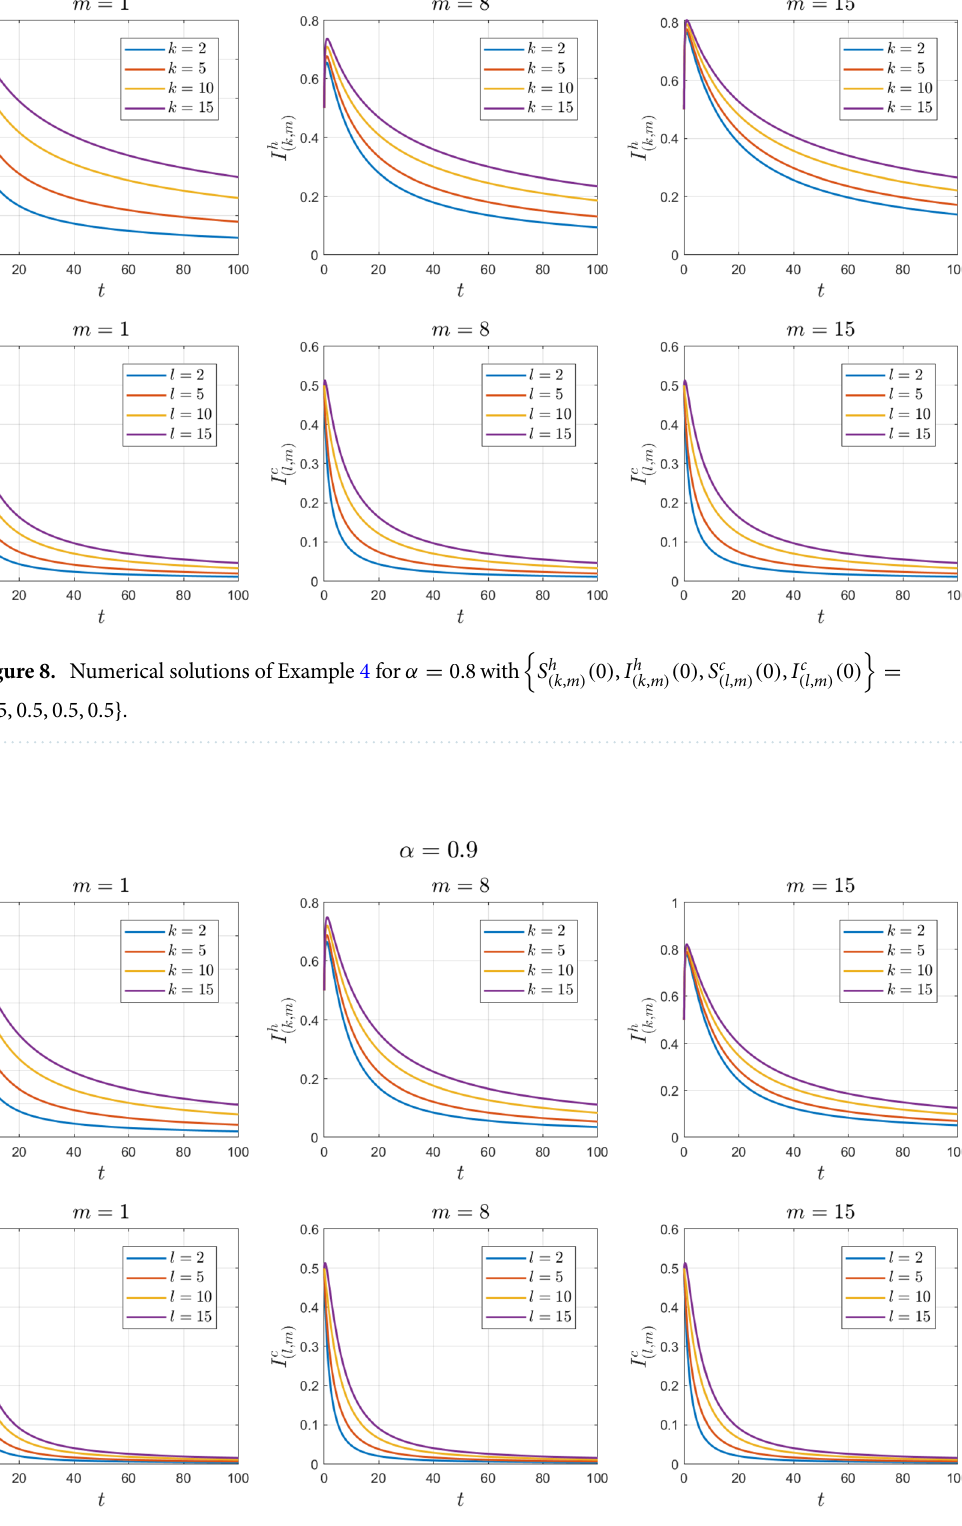
= ( 0 ) , I h ( 0 ) , S c ( 0 ) , I c ( 0 ) S h ( k , m ) ( k , m ) ( l , m ) ( l , m ) (cid:31) (cid:30)